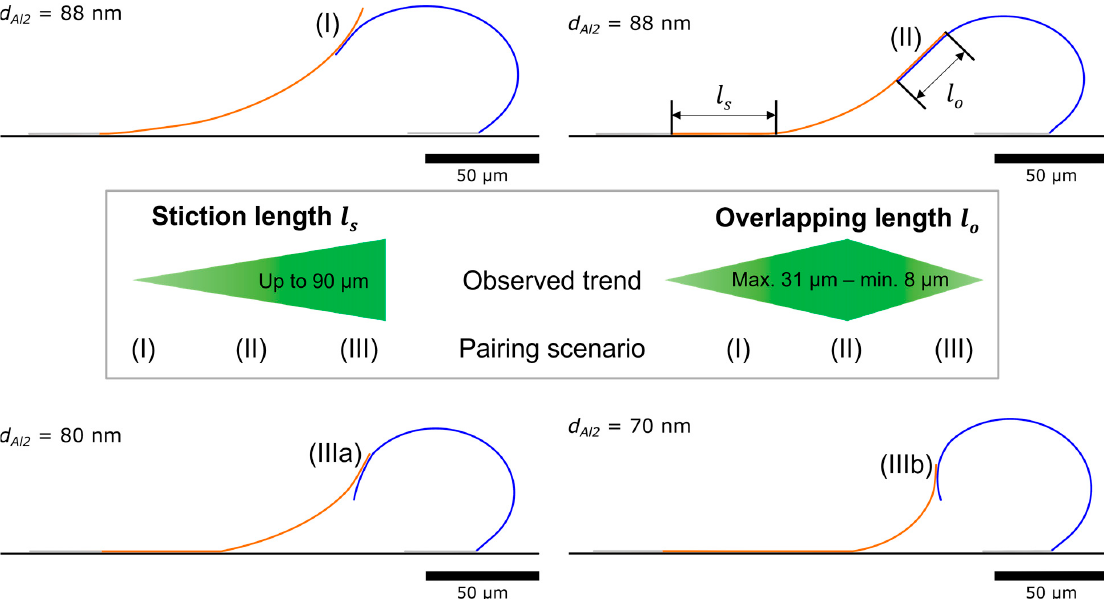
Figure 9. Illustration of different pairing scenarios: (I) shutter A curls at the top part of the overlapping area, (II) shutter A and B are fully flat inside the overlapping area, (IIIa) shutter B curls at the lower part, and (IIIb) shutter B curls even more. In the centre of the figure is a representation of the measured overlapping length l o , ranging between a maximum of 31 µm (II) and a minimum of 8 µm (III), and the stiction length l s is observed to be 0 µm for scenario (I) increases up to 90 µm for scenario (III). The anchor of each shutter is shown in grey.